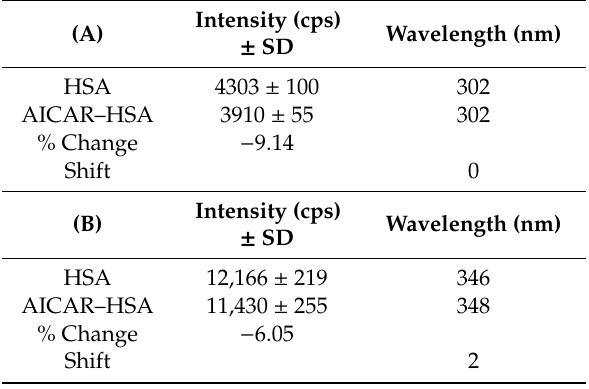
Table 4. The synchronous fluorescence data for HSA and AICAR–HSA (1 / 1 ratio) ( A ) ∆ λ = 15 nm, and ( B ) ∆ λ = 60